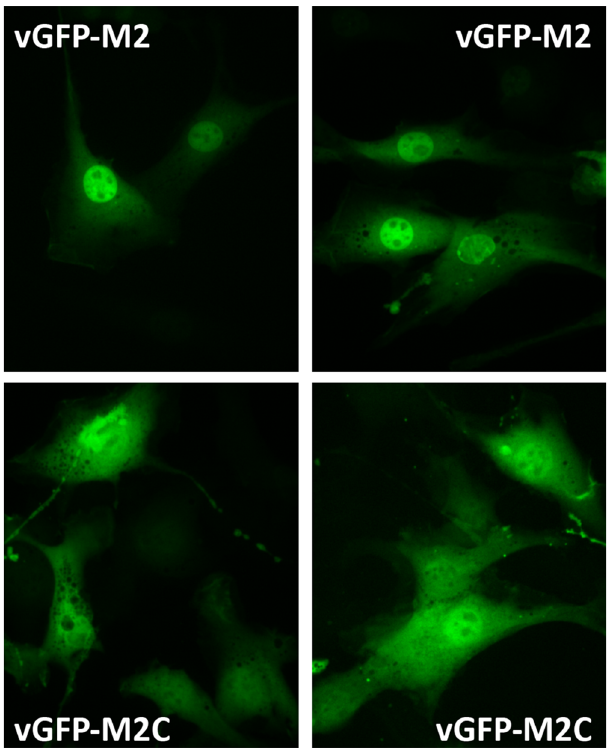
Figure 7. Live cell imaging of T22 cells transfected with plasmids expressing vGFP-M2 (top row) or vGFP- M2C (bottom row). Four z-stacks were taken using a spinning disk confocal fluorescence microscope. Images are projections of sum slices of the z-stacks.